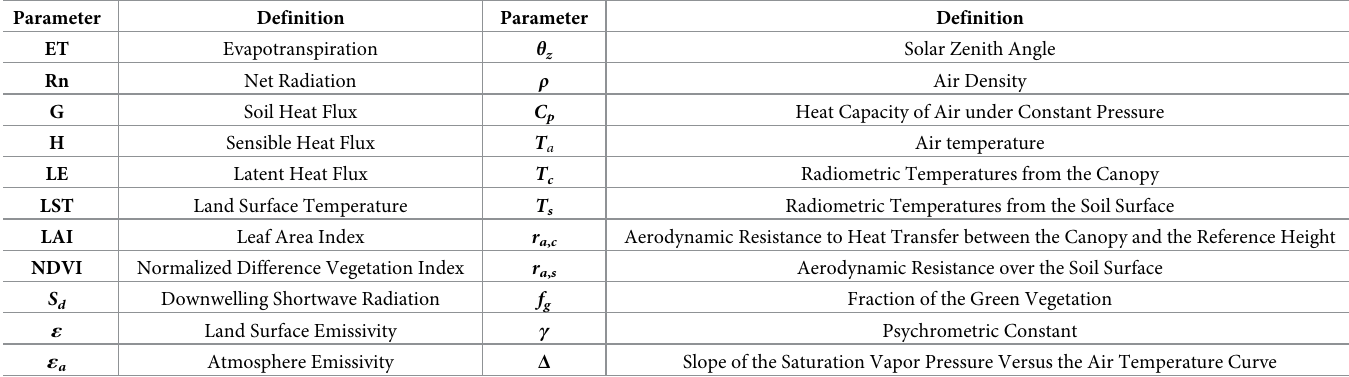
Table 1. Parameters used in this